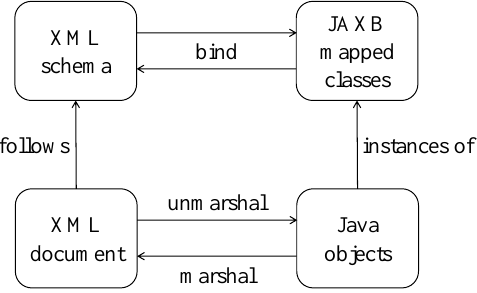
Figure 2. The JAXB binding process. Adapted from Oracle Corporation,